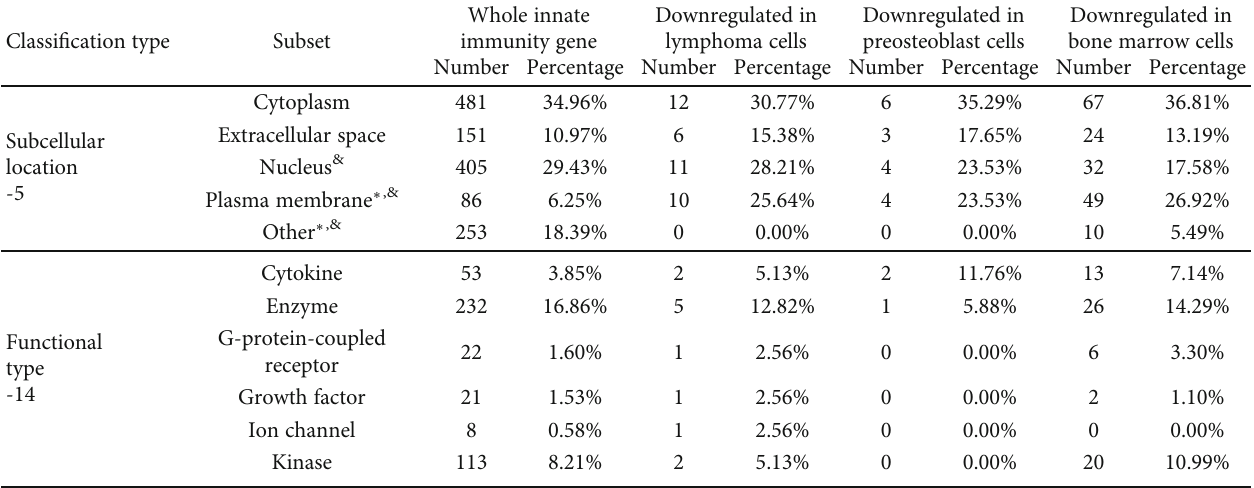
downregulated innatomic genes in lymphoma cells, preosteoblasts, and bone marrow cells are signi fi cantly changed. However, one of the